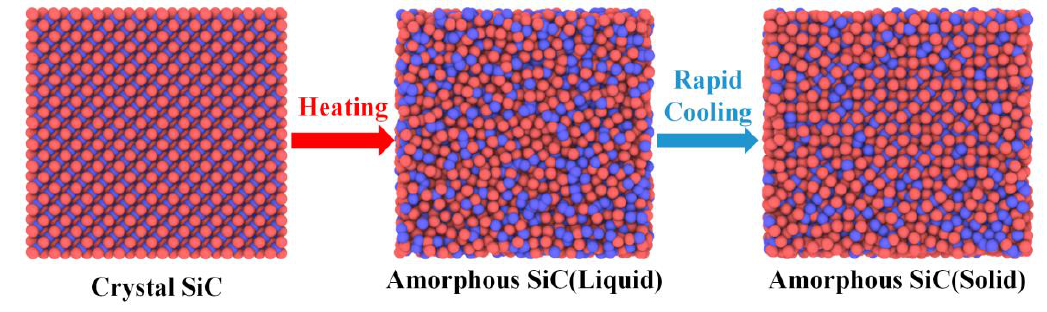
Figure 9. The typical amorphization simulation model of SiC [76,77].